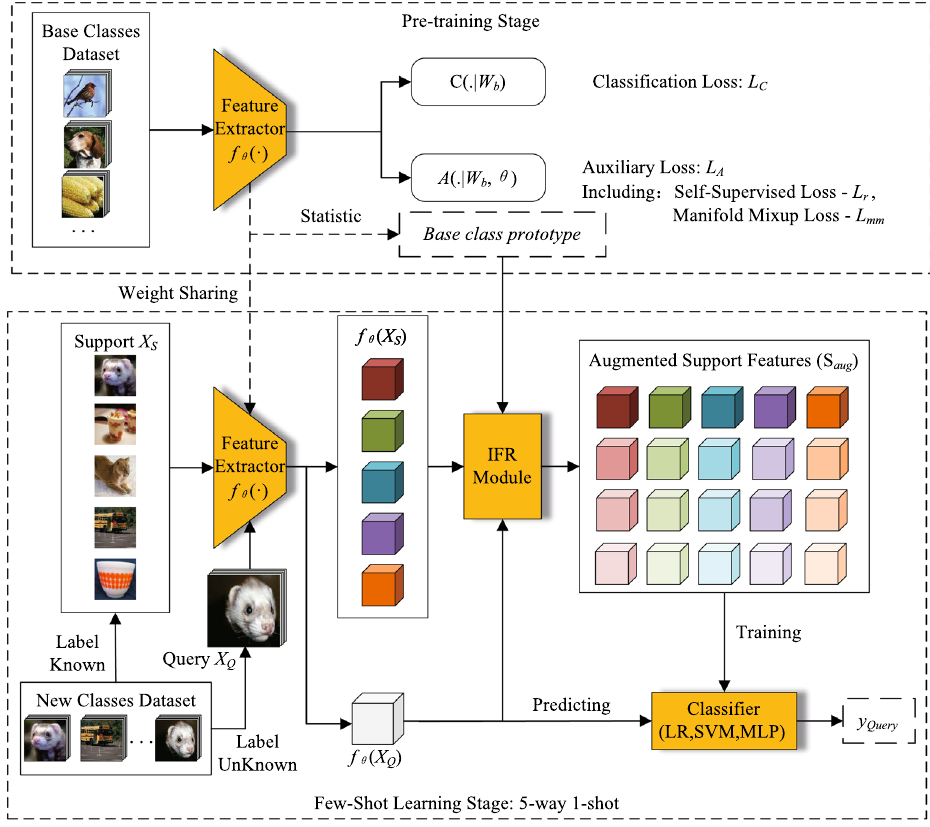
Figure 2. The framework of few-shot learning with IFR based feature augmentation (5-way